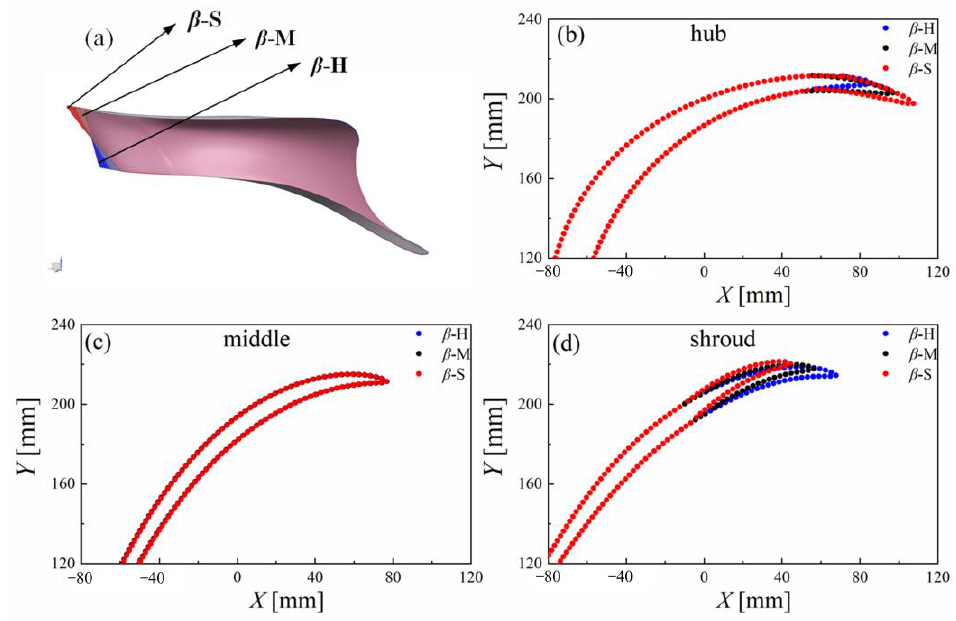
Figure 8. Blade geometry comparison in typical planes: ( a ) blade geometric modeling, ( b ) hub, ( c ) middle, and ( d ) shroud.